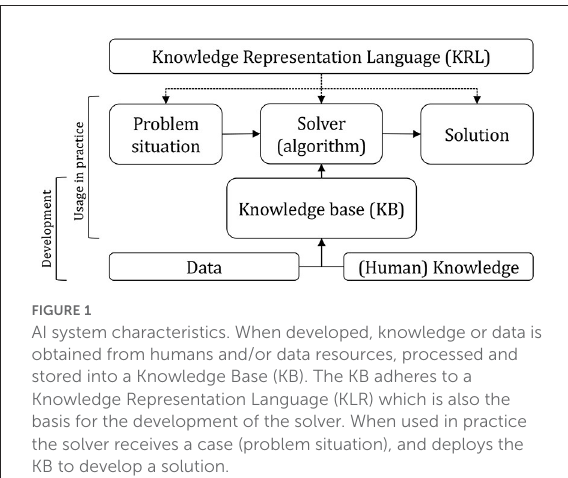
FIGURE1 AI system characteristics. When developed, knowledge or data is obtained from humans and/or data resources, processed and stored into a Knowledge Base (KB). The KB adheres to a Knowledge Representation Language (KLR) which is also the basis for the development of the solver. When used in practice the solver receives a case (problem situation), and deploys the KB to develop a